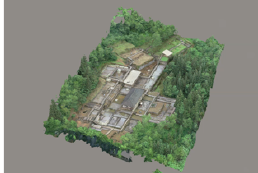
Figure 18 . Point cloud data for Erdao Gate, Hailongtun, after restoration.